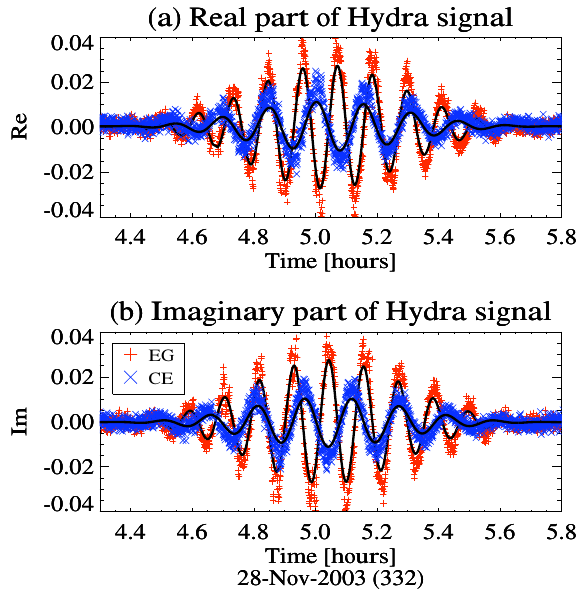
Fig. 3. Fringe fitting. Measured (red ( + ) and blue ( × ) and fitted (black) real (top) and imaginary (bottom) Hydra cross-correlation components for selected pair of